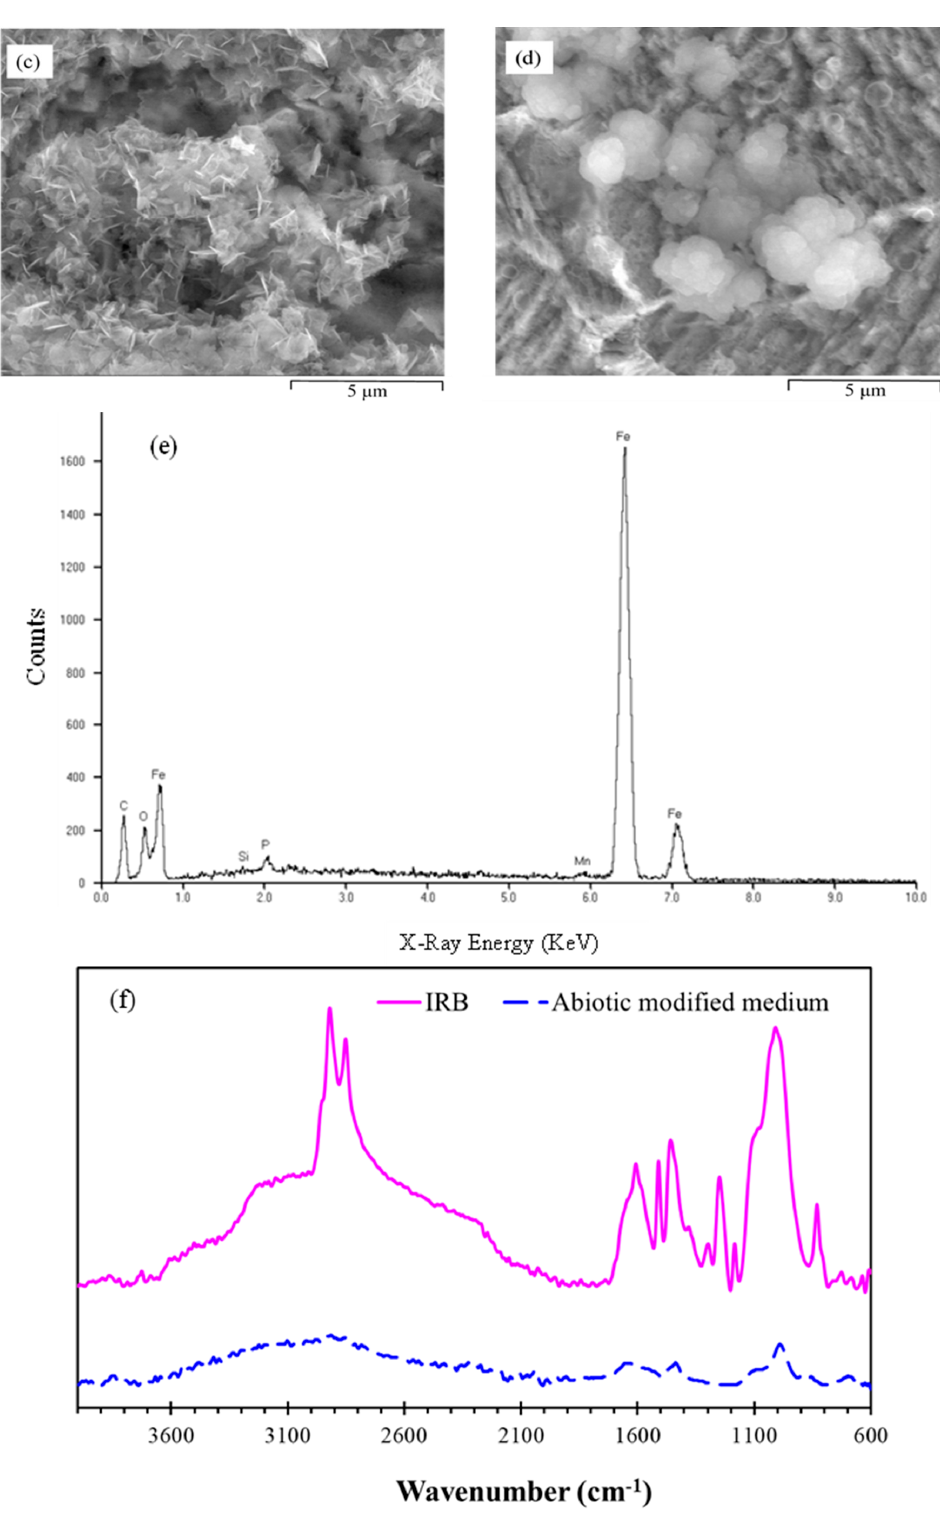
Figure 7. ESEM analysis of hydrated biofilm formed on carbon steel by a pure IRB culture following 72 h exposure to modified Postgate C medium: appearance of uniform corrosion ( a ) across the surface of carbon steel, a hollow iron oxide shell ( b ) at the surface of a corrosion pit, and needle ( c ) and globular ( d ) forms of reduced iron oxyhydroxide compound. ( e ) EDS spectra of the biofilm. ( f ) IR spectra of IRB biofilm formed on carbon steel exposed to pure IRB culture in modified Postgate C medium for a period of 72